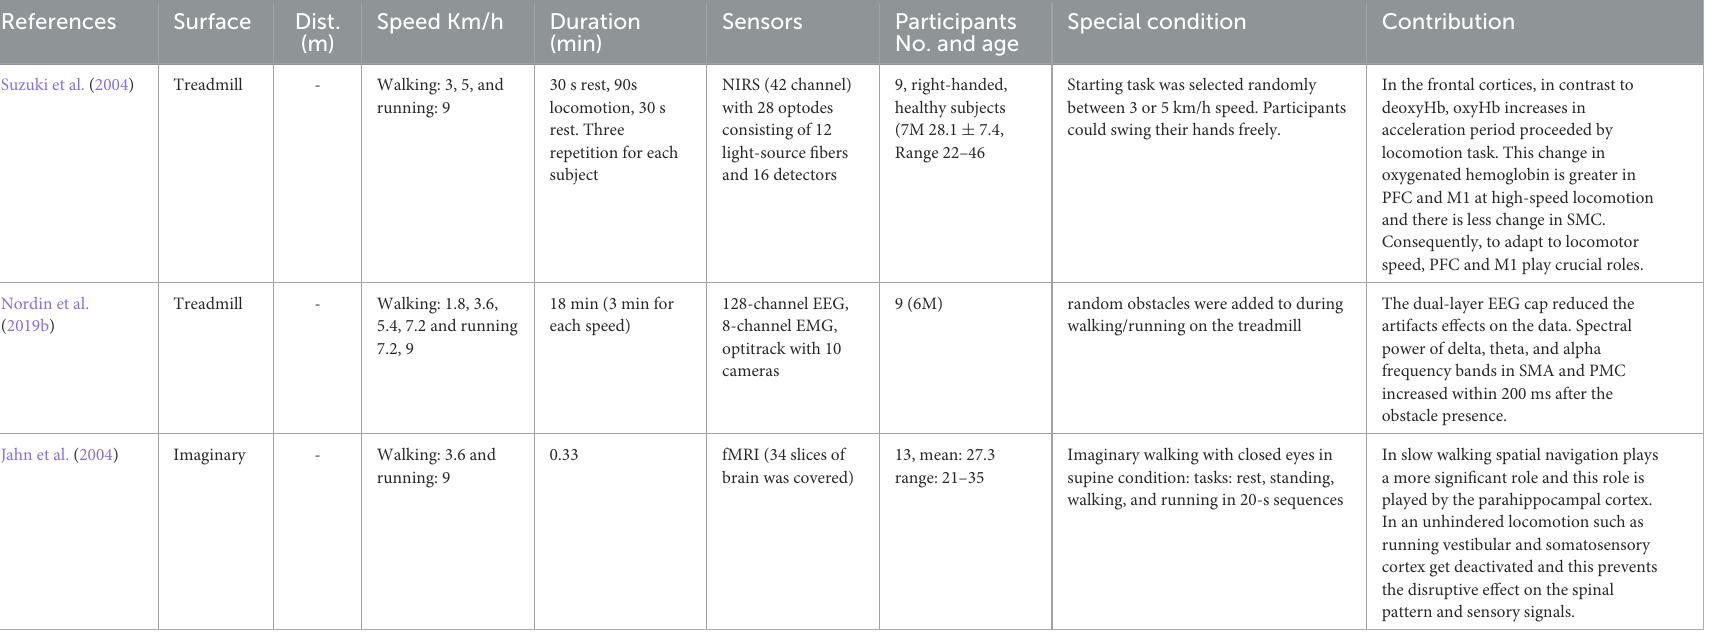
TABLE 5 Brain-body imaging in